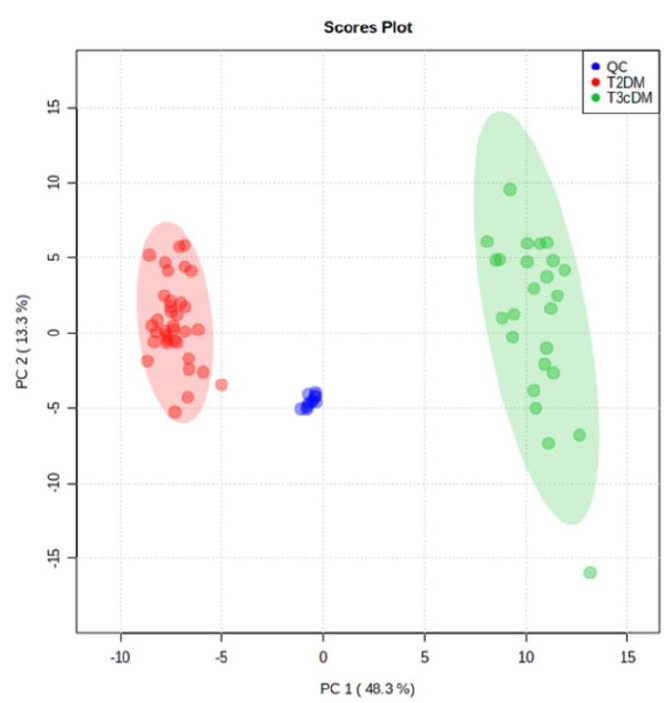
Figure 2. Principal component analysis score plot of TD2DM (red), T3cDM (green), and quality control (QC) samples (blue).